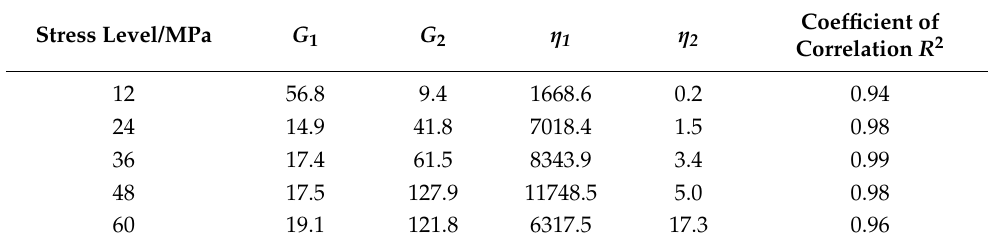
natural state increases nonlinearly with the bedding angle, and the relationship among the instantaneous elastic modulus of all loading levels and bedding angle is expressed as: